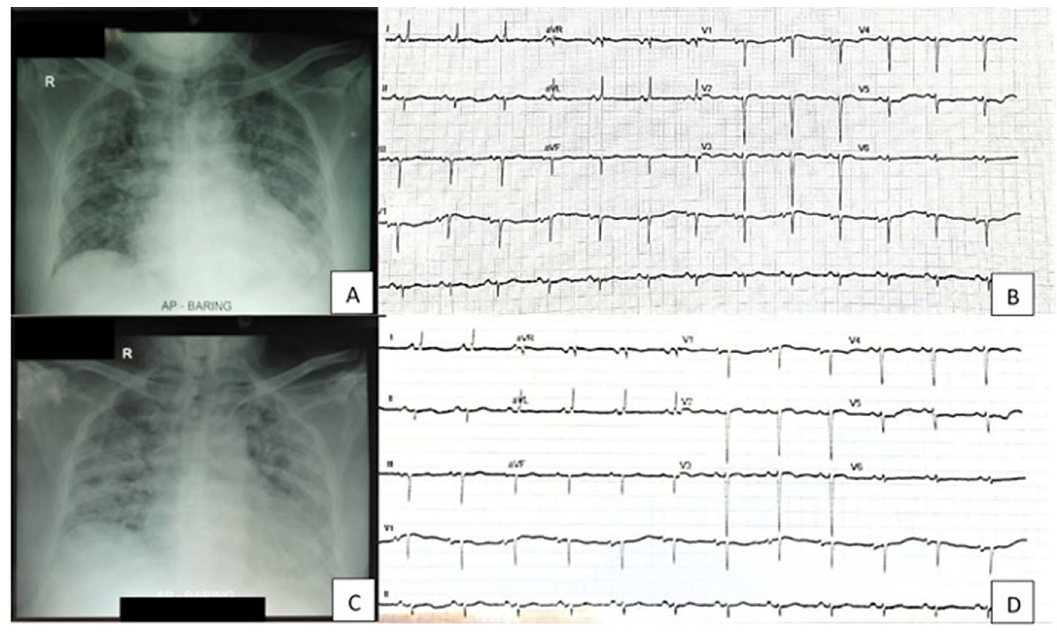
Figure 1. Radiology and electrocardiography (ECG) comparison of patient on first day admission (A, B) and ninth day admission (C,